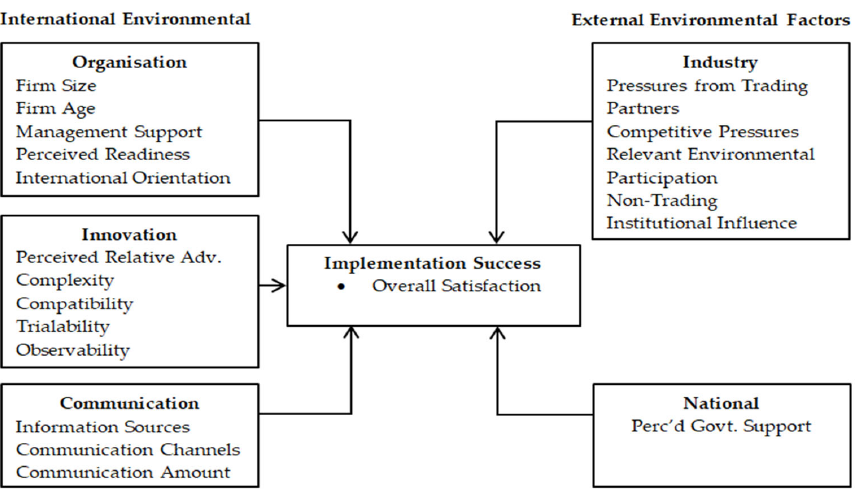
Figure 1. Influence factor of implementation success of e ‐ commerce diagrams [51].